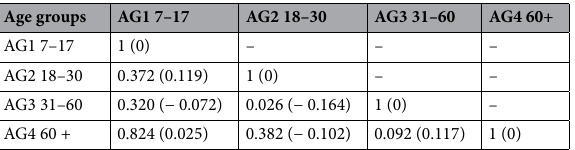
Table 5. p-values and effect size η groups.